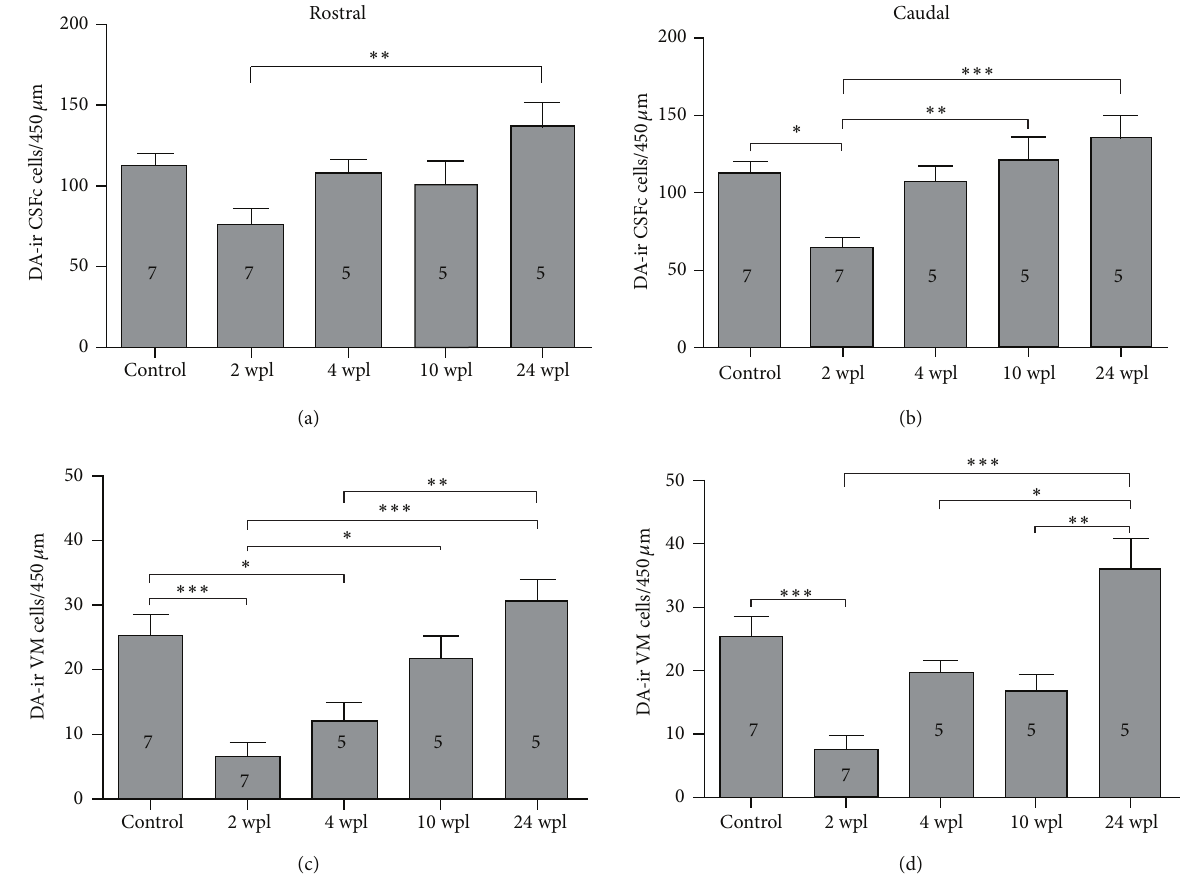
Figure 4: Dopaminergic cell numbers are recovered after a complete spinal cord injury. (a) Quantification of CSFc dopamine-ir cells in the rostral spinal cord (ANOVA, 𝑃 = 0.0049 with Bonferroni’s posttest, ∗∗∗ 𝑃 < 0.0001 ). (b) Quantification of CSFc dopamine-ir cells in the caudal spinal cord (ANOVA, 𝑃 = 0.0006 with Bonferroni’s posttest, ∗ 𝑃 < 0.05 , ∗∗ 𝑃 < 0.01 , and ∗∗∗ 𝑃 < 0.0001 ). (c) Quantification of VM dopamine-ir cells in the rostral spinal cord (ANOVA, 𝑃 < 0.0001 with Bonferroni’s posttest, ∗ 𝑃 < 0.05 , ∗∗ 𝑃 < 0.01 , and ∗∗∗ 𝑃 < 0.0001 ). (d) Quantification of VM dopamine-ir cells in the caudal spinal cord (ANOVA, 𝑃 < 0.0001 with Bonferroni’s posttest, ∗ 𝑃 < 0.05 , ∗∗ 𝑃 < 0.01 , and ∗∗∗ 𝑃 < 0.0001 ).